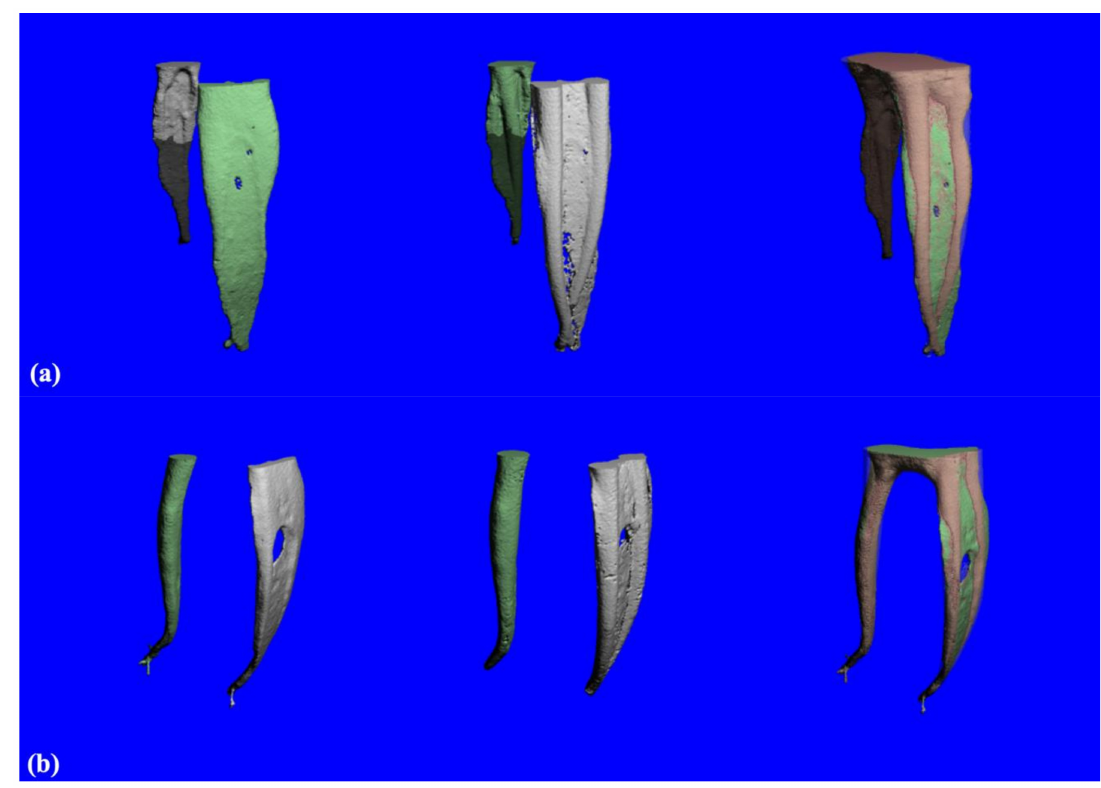
Figure 1. ( a ) 3D-constructed images from the TF Adaptive group of root canal system before (left) and after (middle) instrumentation and superimposed image (right) from the mesial. ( b ) 3D constructed images from BioRace group of root canal system before (left) and after (middle) instrumentation and superimposed image (right) from the mesial. Green indicates un-instrumented areas while red indicates instrumented areas. Figure 2a shows cross-section images from different levels: 700 µ m (top), 950 µ m (middle), and 1200 µ m (bottom) obtained from micro-CT image before (images on